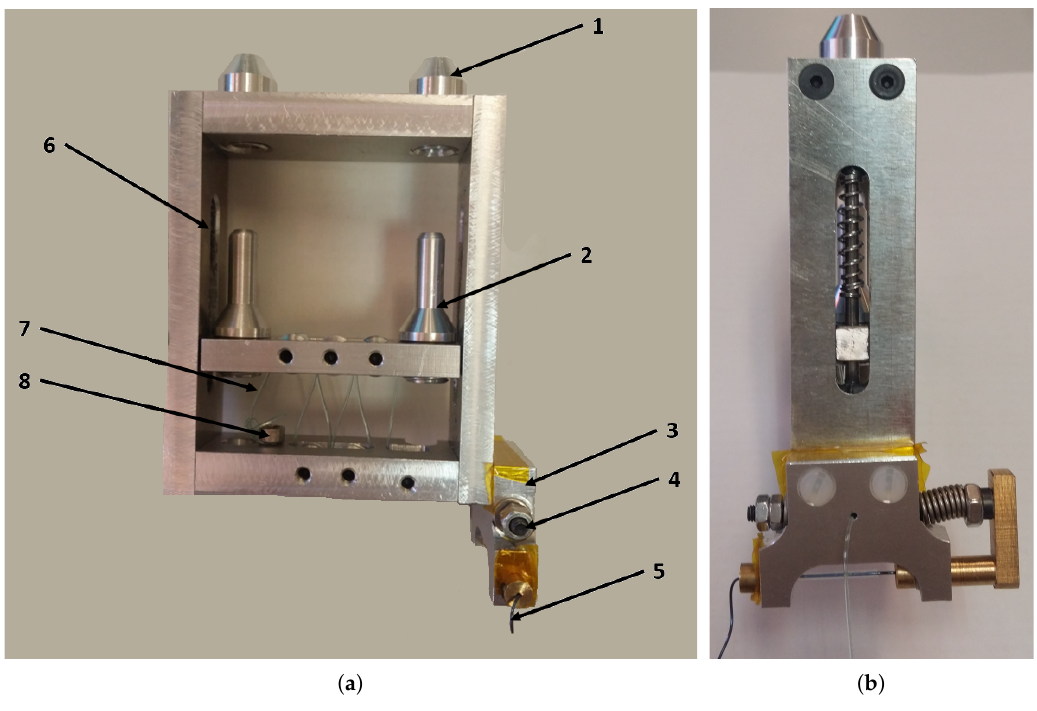
Figure 17. Brake gear 1:6 actuator. ( a ) Front view; ( b ) Lateral